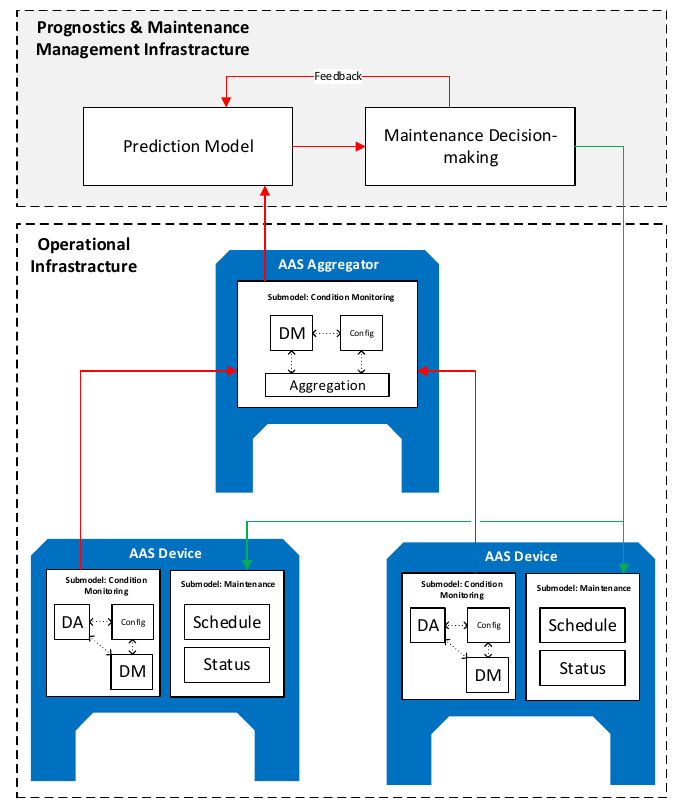
Figure 4. AAS-based PdM model for predictive maintenance. DM: data manipulation; DA: data acquisition.